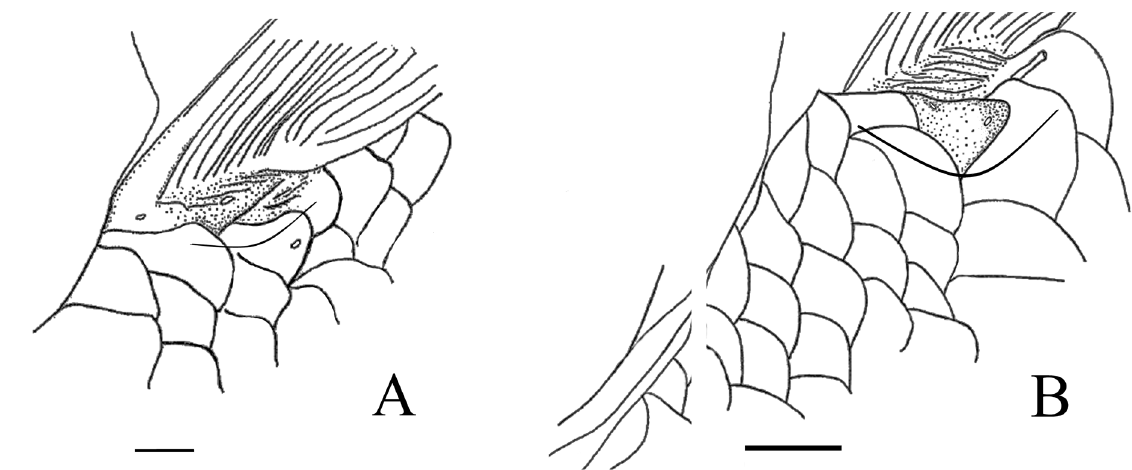
Fig. 9. Squamation of pectoral-fin base, ventral view. A . Astyanax bimaculatus ( Linnaeus, 1758 ). B . Astyanax yariguies ( Torres-Mejía, Hernández & Senechal, 2012 ) comb. nov. In A, the pore of pectoral-fin is in epithelial tissue, covered or circumscribed by three scales indicated by the curved line, while in B, the pore of the base of pectoral-fin is part of a scale circumscribed by four scales, indicated by the curved line. Scale bars =